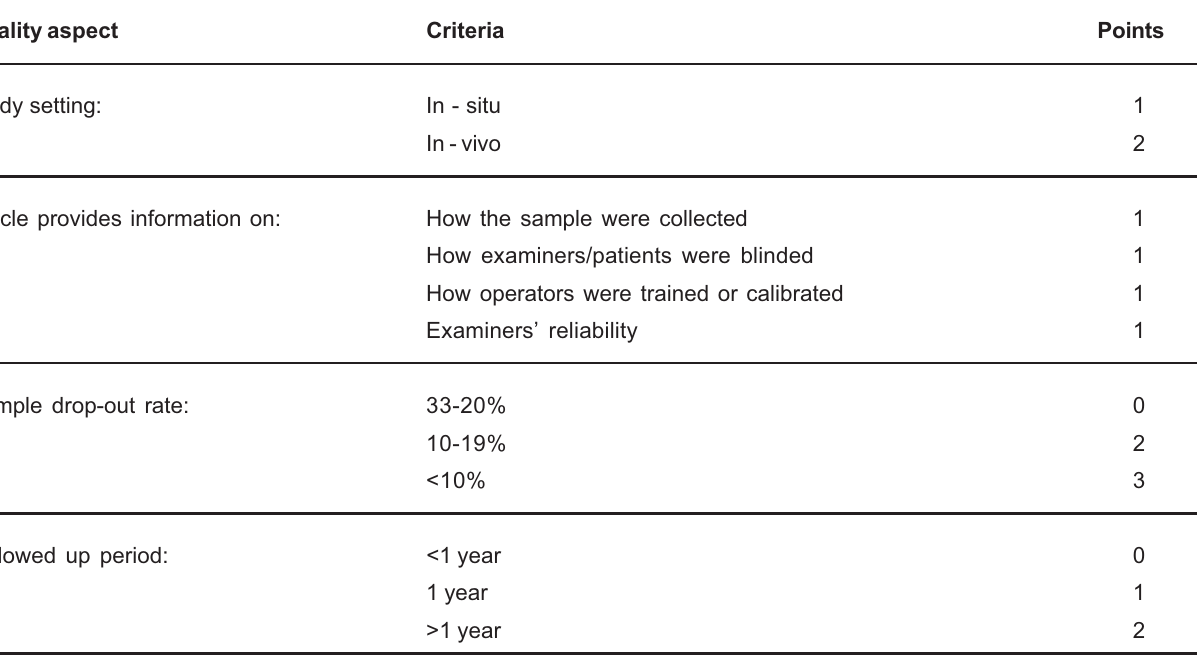
Quality scores (Total number of points): ‘Strong evidence’ = 10-11 ‘Good evidence’ = 6-9 ‘Reasonable evidence’ =